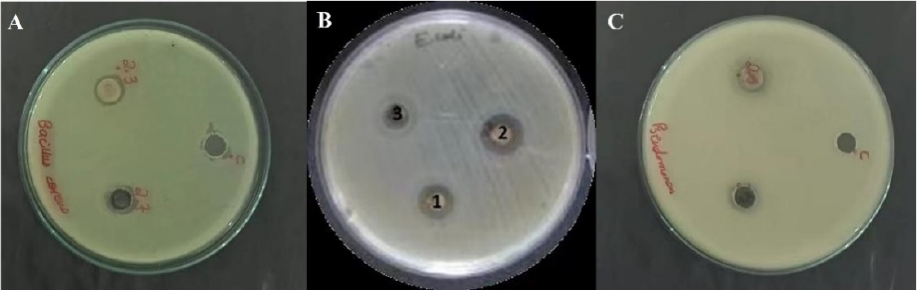
Figure 6. Antibacterial activity of ZnO-NPs and CNTs/ZnOcomposite on ( A ) Bacillus cereus , ( B ) Escherichia coli ,and ( C ) Pseudomonas aeruginosa.